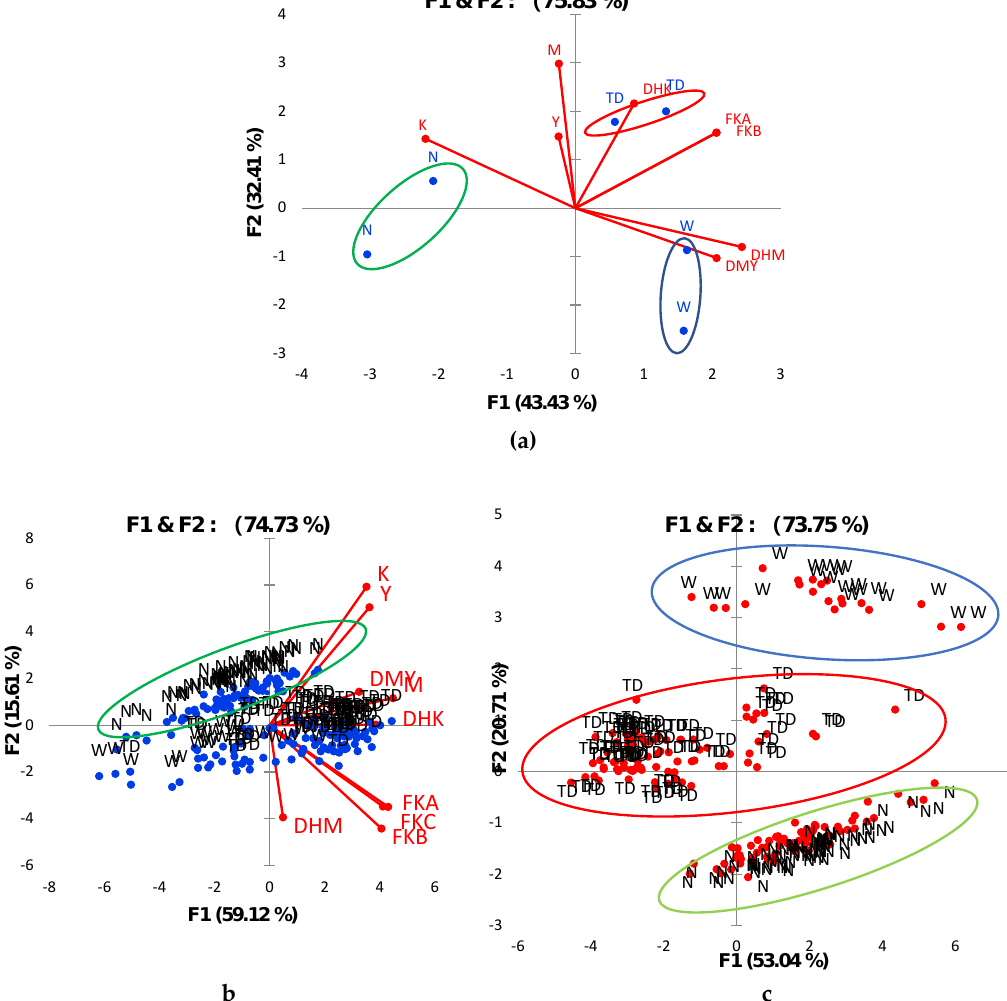
Figure 3. ( a ) PCA of a subset of six varieties representing the genetic diversity of the species analyzed by UHPLC (peak area values were used) shows that the three groups of varieties (N, TD, W) are well differentiated. ( b ) PCA of 174 varieties analyzed by HPTLC (peak area values) and the contribution of the nine variables shows that the N varieties are well differentiated but some TD varieties are clustering with W varieties. ( c ) PCAmix identifying nearness between variables and proximity between the 174 observations (N = 72 acc., TD = 82 acc., W = 20 acc.) shows that the three groups are well separated.